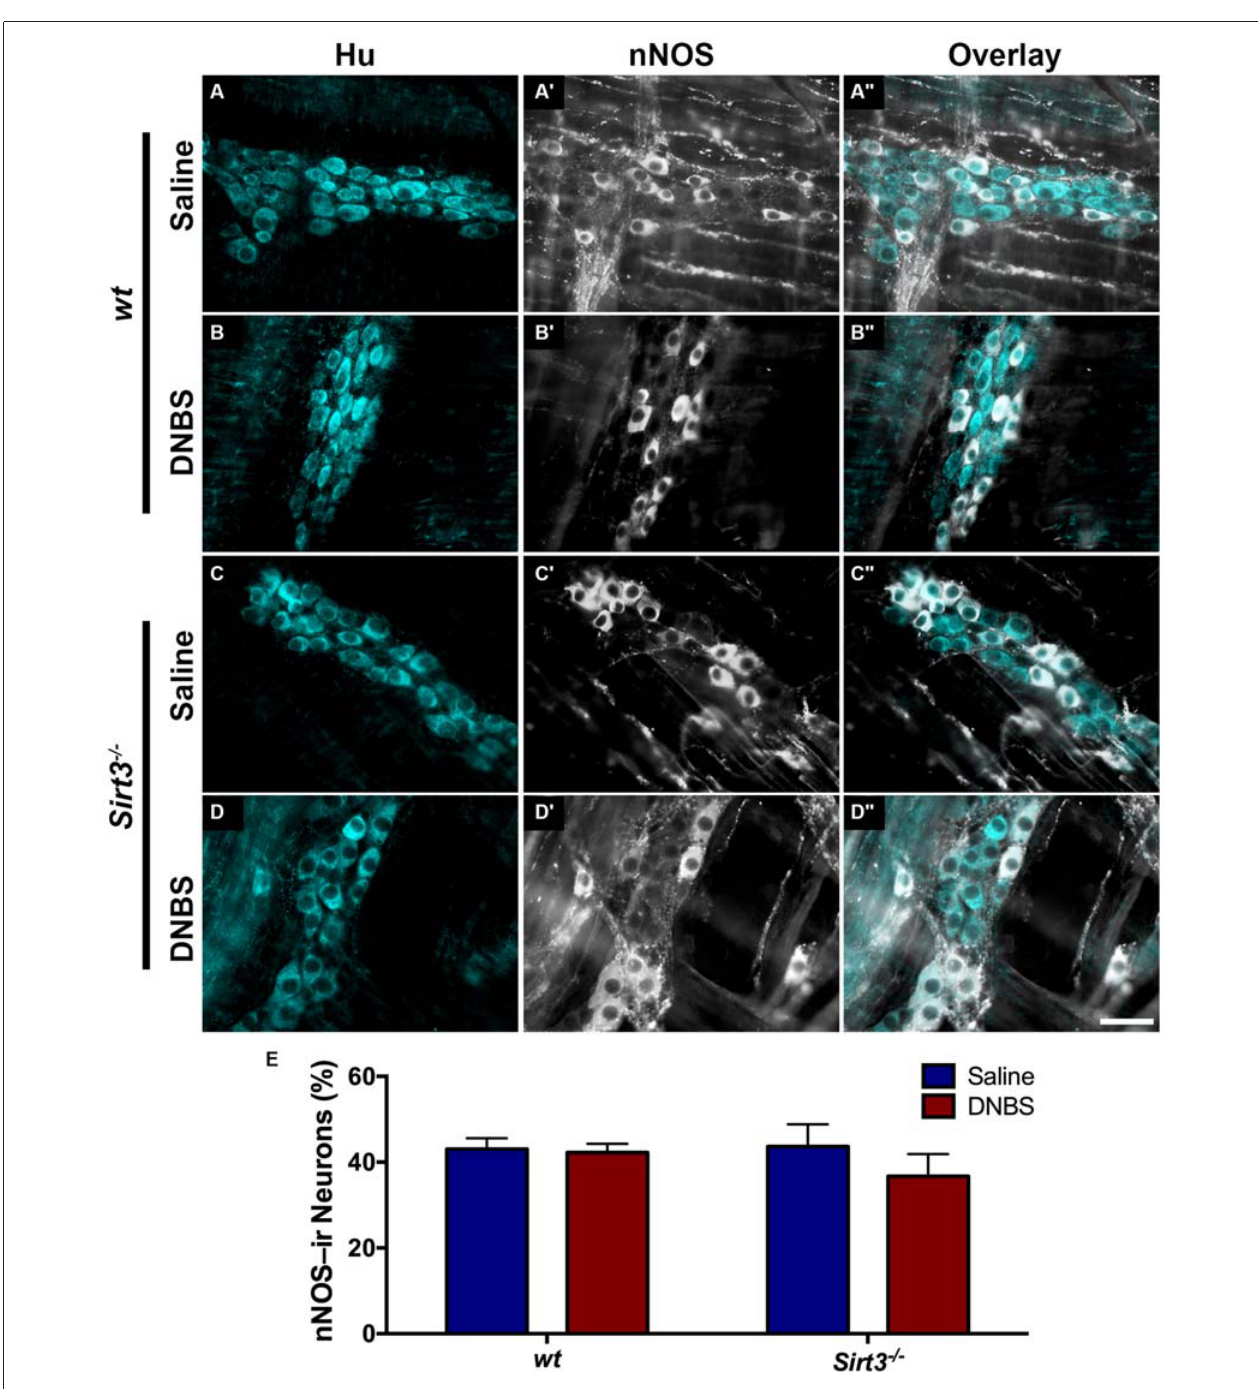
FIGURE 8 | The percentage of myenteric neurons that express nNOS is not altered by DNBS-colitis in wt or Sirt3 − / − mice. (A–D”) show dual-label fluorescence immunohistochemistry for HuC/D (cyan, A–D ) and nNOS (grayscale, A’–D’ ) in myenteric ganglia from saline- (A–A”,C–C”) or DNBS-treated (B–B”,D–D”) mice. Overlays are shown in (A”–D”) . Scale bar in D” = 50 µ m and applies to all images. (E) Quantification of the percentage of HuC/D immunoreactive neurons that also display immunoreactivity for nNOS in healthy and inflamed mice with wt or Sirt3 − / − genotypes ( n = 4–5 animals per group, P > 0.05, 2-way